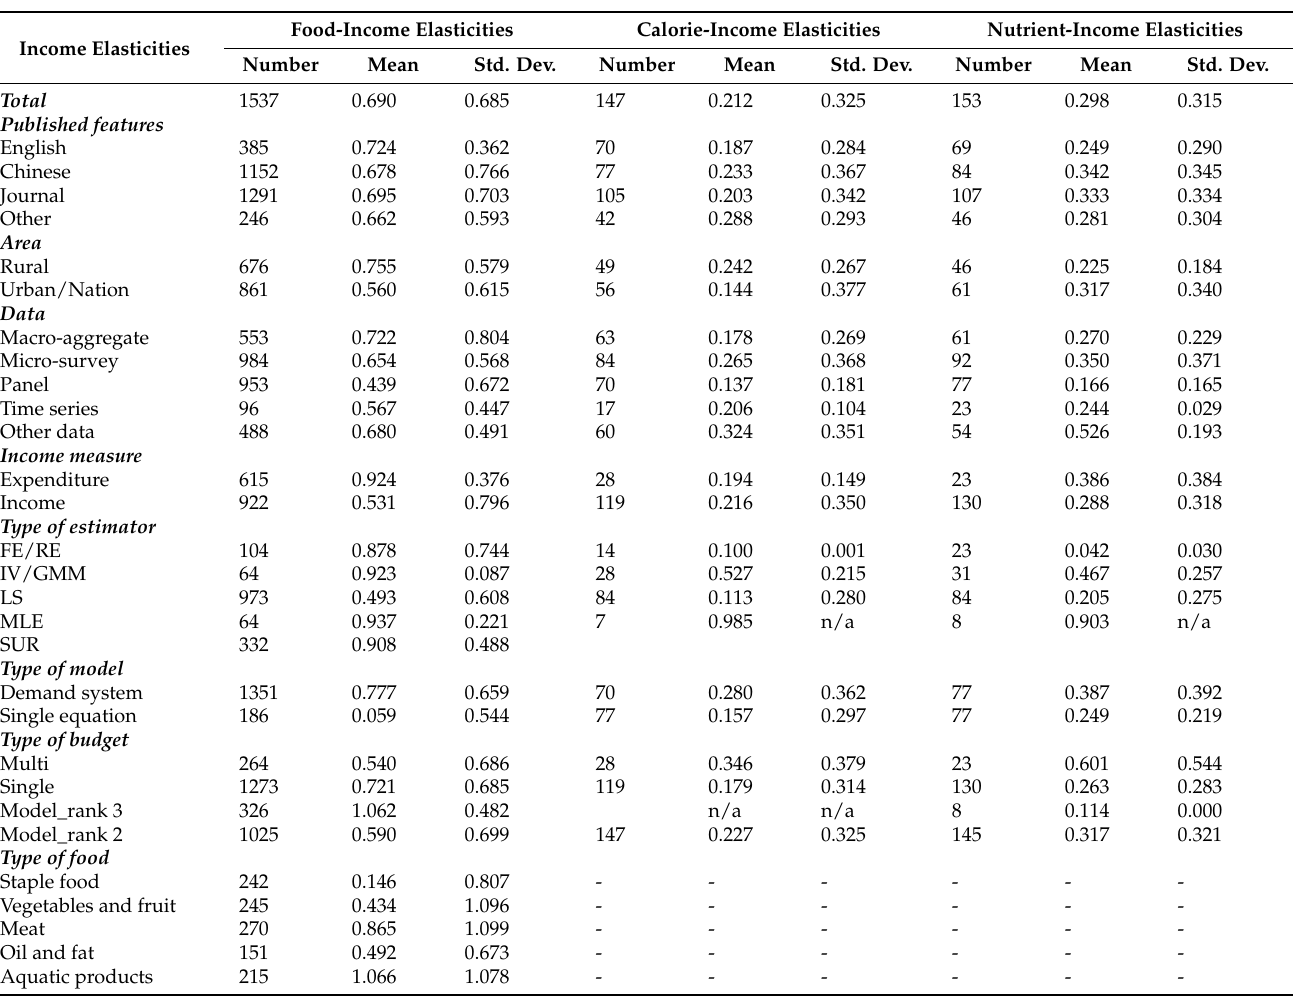
Table 1. Summary statistics of